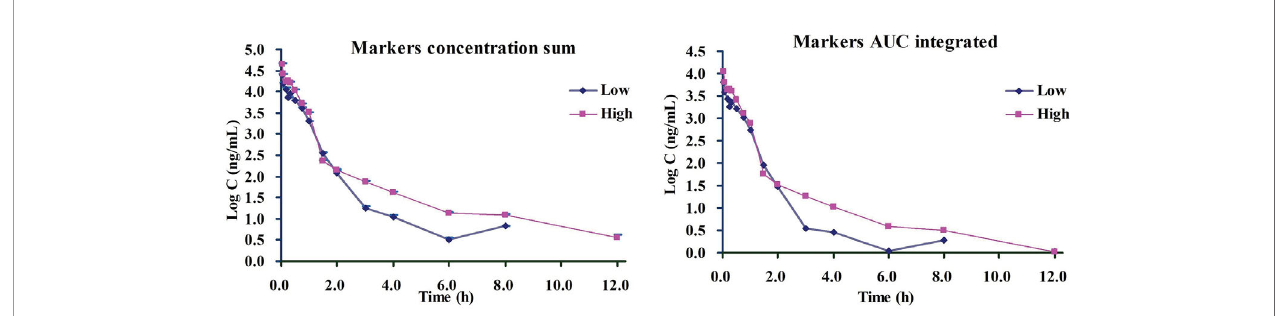
FIGURE 8 | The drug plasma concentration-time curves by two integrated methods for i.v. administration of Acanthopanax senticosus extract preparation (ASEP) (low and high dosages) (Mean ± SD, n